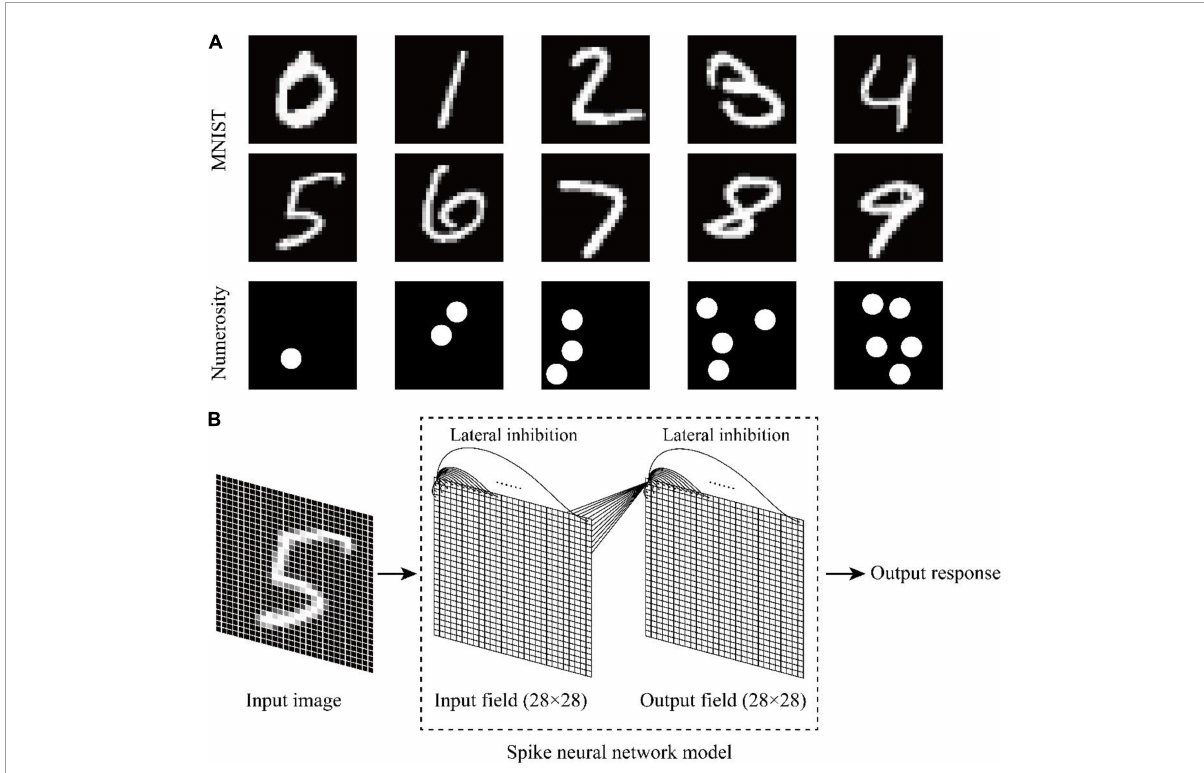
FIGURE1 Schematic of the dataset and neural network structure. (A) Symbolic number dataset MNIST and non-symbolic numerosity dataset. (B) Two-layer spike neural network model with lateral inhibition.